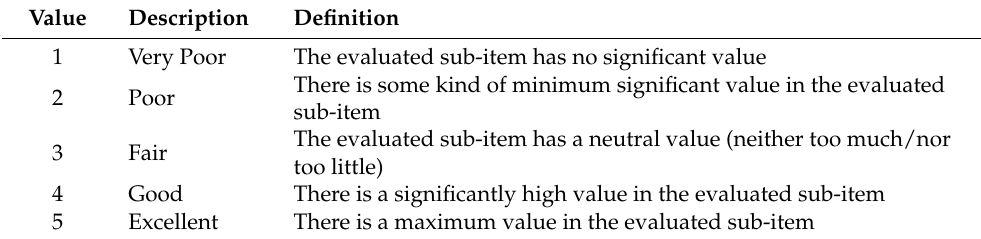
Table 5. Scale of values to be evaluated.